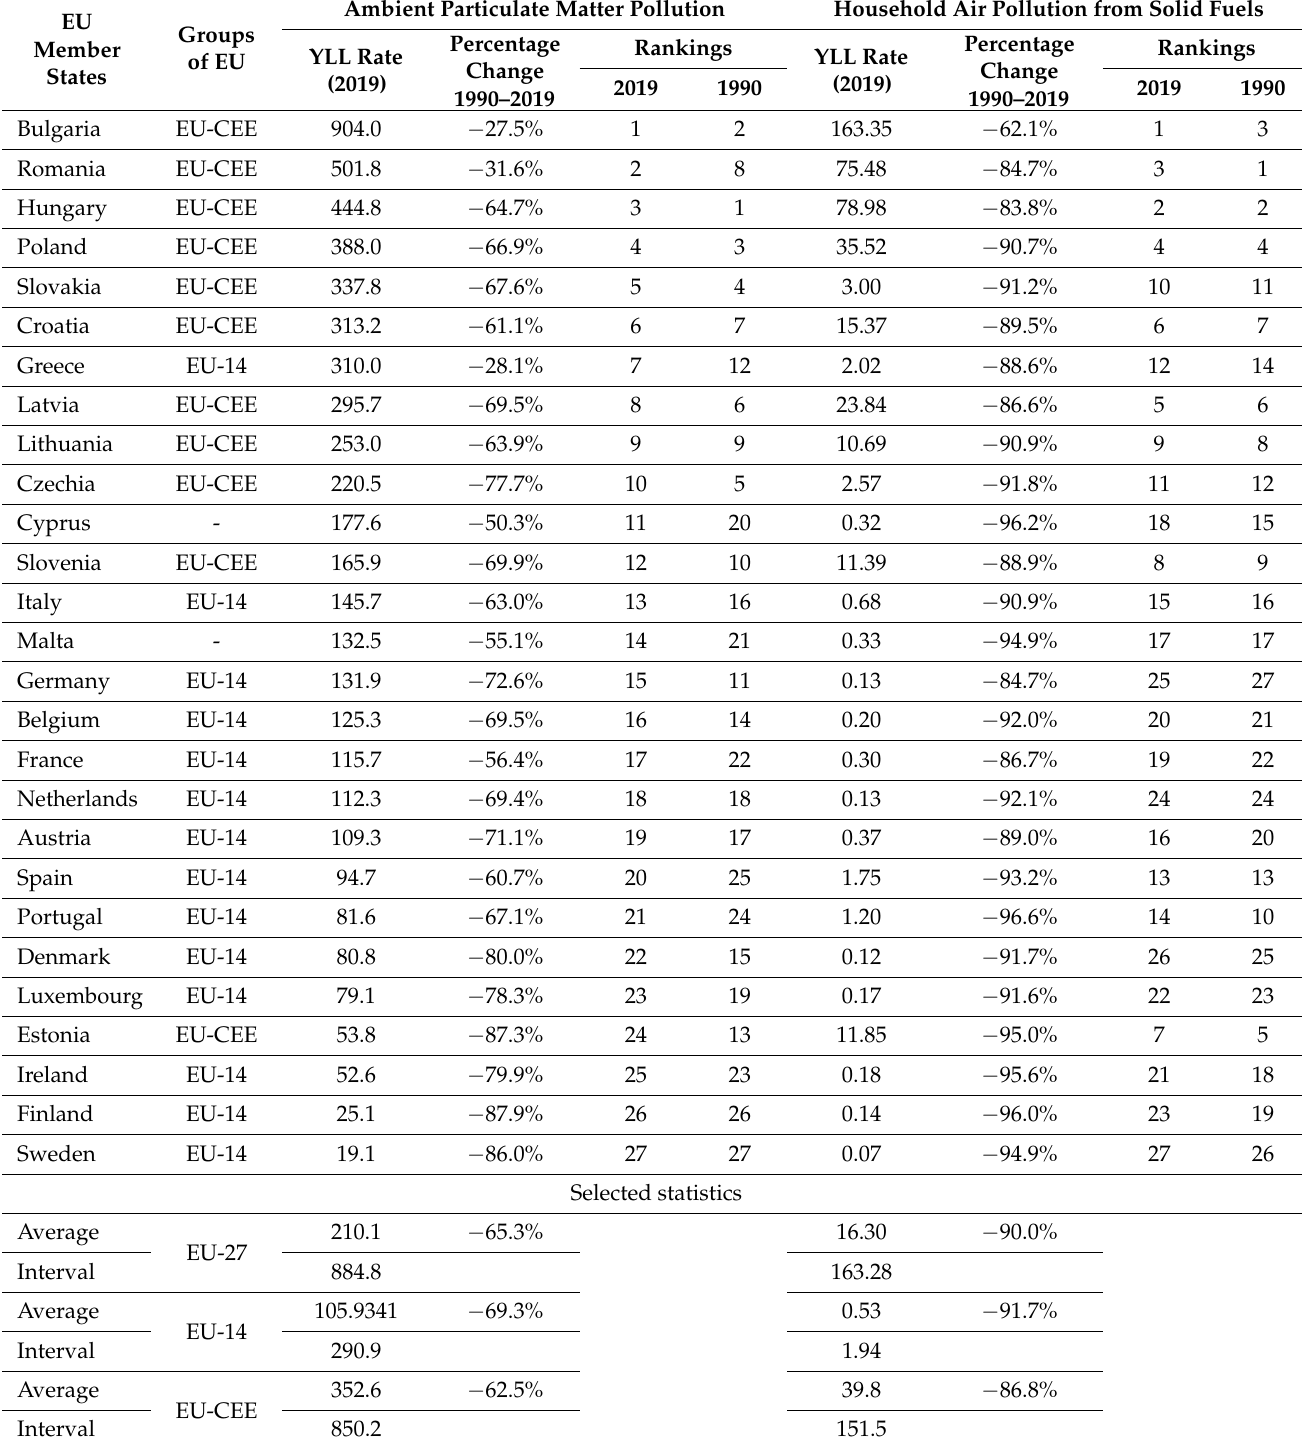
Table 1. Number of years of life lost (YLL) due to chronic diseases as a result of air pollution